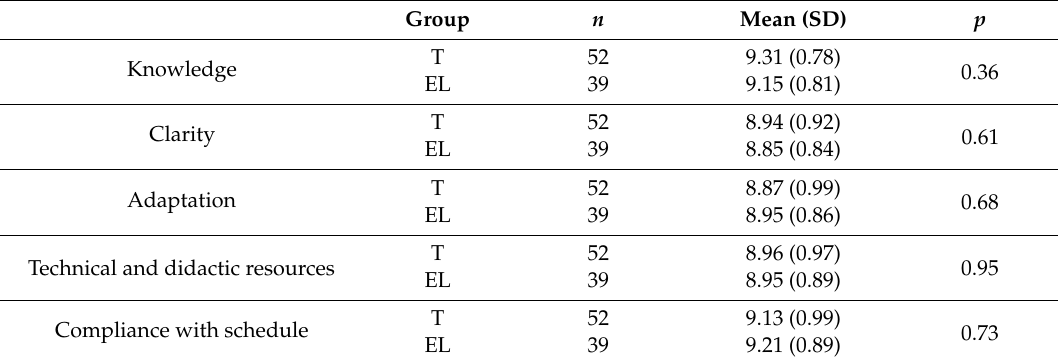
Table 5. Evaluation of teachers by students in experimental groups (EL) and control groups (T).